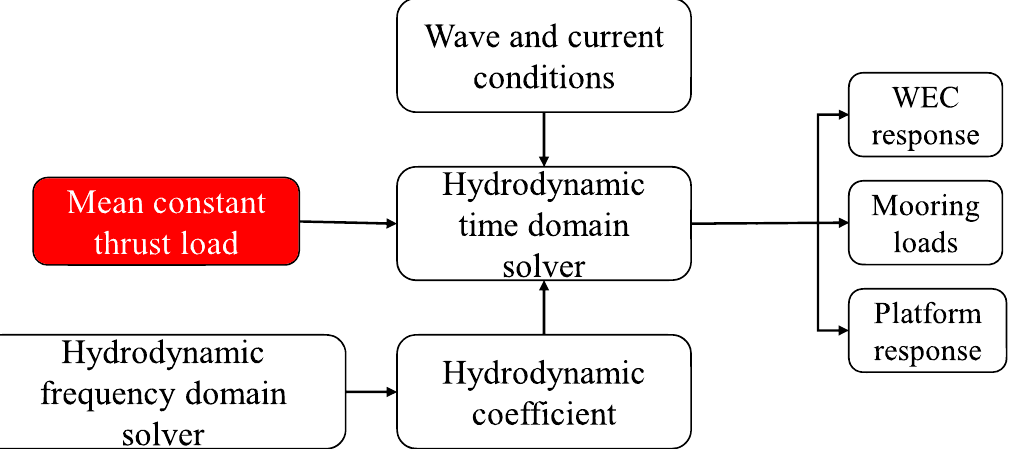
Figure 10. Schematic diagram of wind ‐ wave coupling simulation flow by adding constant aerody ‐ namic loads. namic